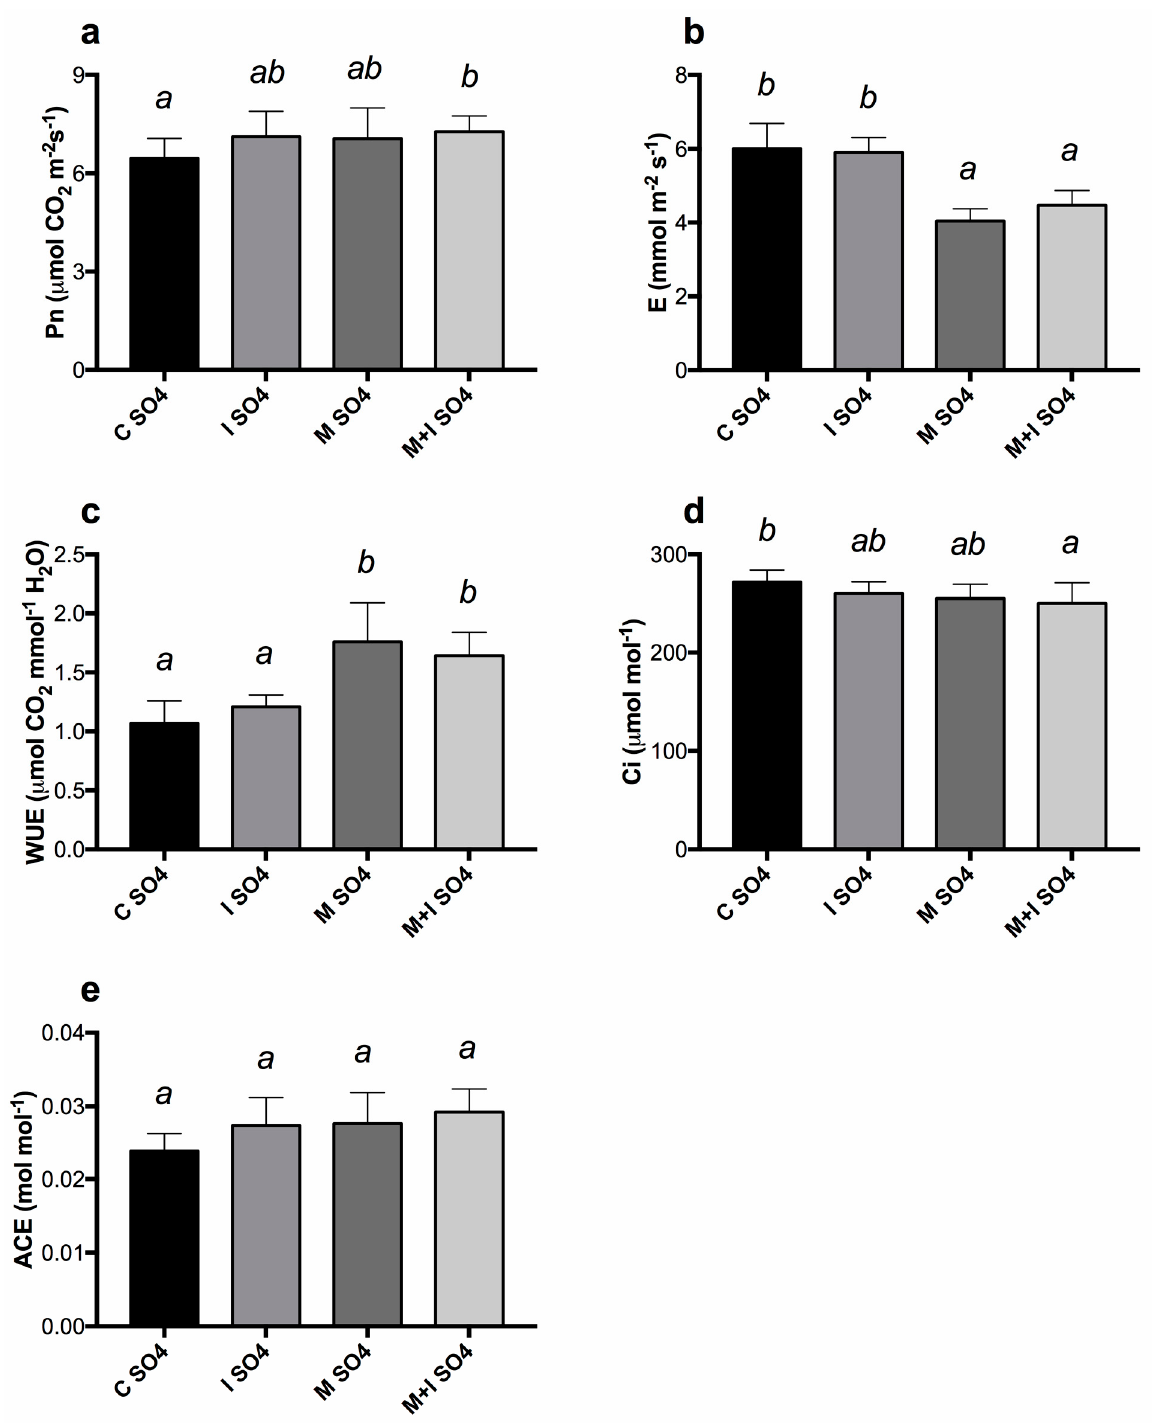
Figure 4. Leaf gas exchange in ‘Glera’ plants grafted onto SO4 rootstock at v é raison. Performances of net photosynthesis (Pn) ( a ), transpirations E ( b ), water use efficiency (WUE) ( c ), intercellular CO 2 concentration (Ci) ( d ), apparent carboxylation efficiency (ACE) ( e ). Data are expressed as mean ± SD ( n = 10) of randomly selected plants over 2020 and 2021 seasons. Different lowercase letters above the bars indicate significant differences according to Tukey’s HSD test ( p < 0.05). C, control plants; I, Inducer-treated plants; M, AMF mixed inoculum-treated plants; M+I AMF mixed